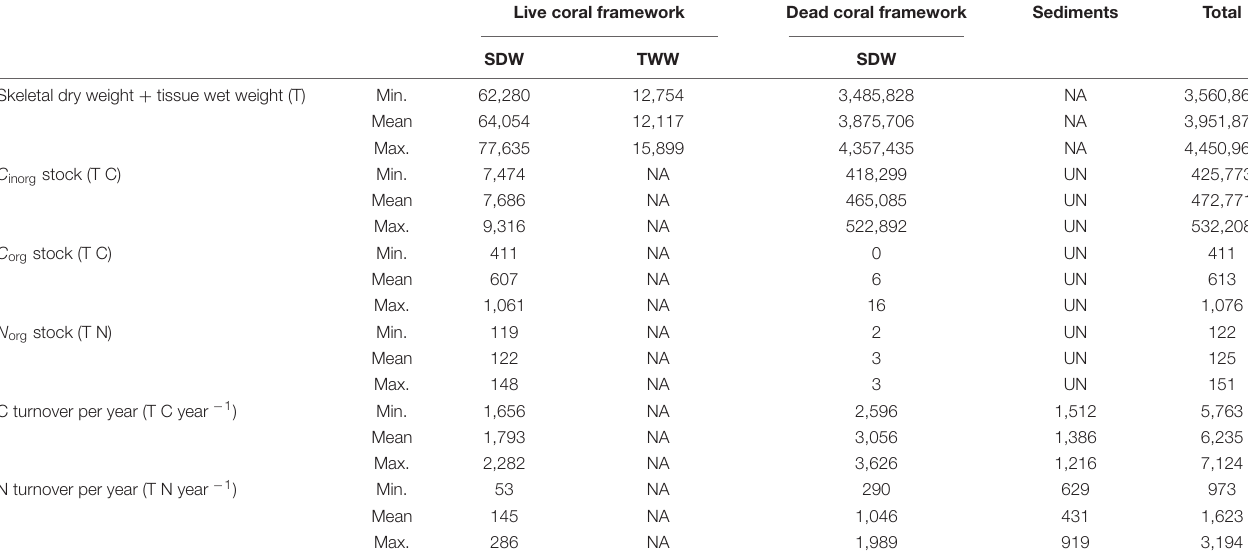
TABLE 4 | Overview of the minimum, mean and maximum (bio)mass, organic and inorganic carbon (C), organic nitrogen (N) stock masses, together with the mass of C and N turned over by live and dead coral framework and sediments. Live coral